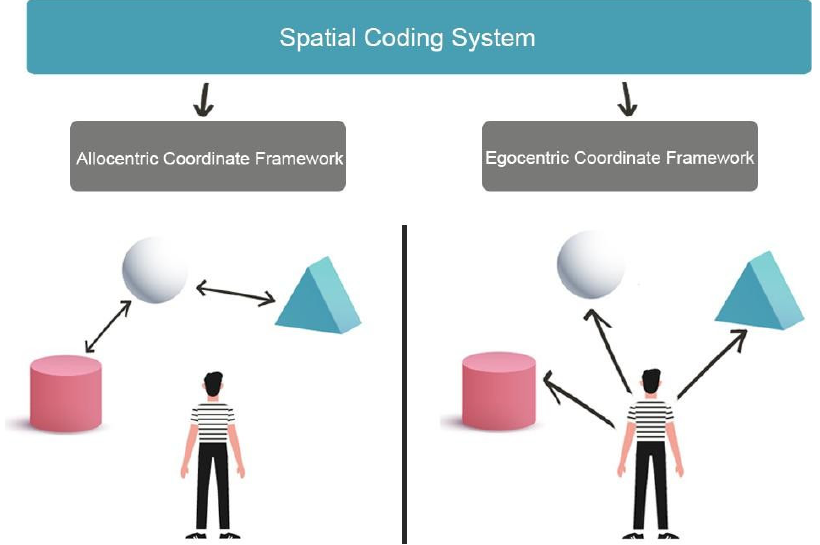
Figure 1. The image shows two different formats of environments representation. Allocentric Coordinate Framework encoding spatial information based on the navigator’s perception of relative landmark positions ( left ). The Egocentric Coordinate Framework bases spatial representations from the point of view of the navigator ( right ).